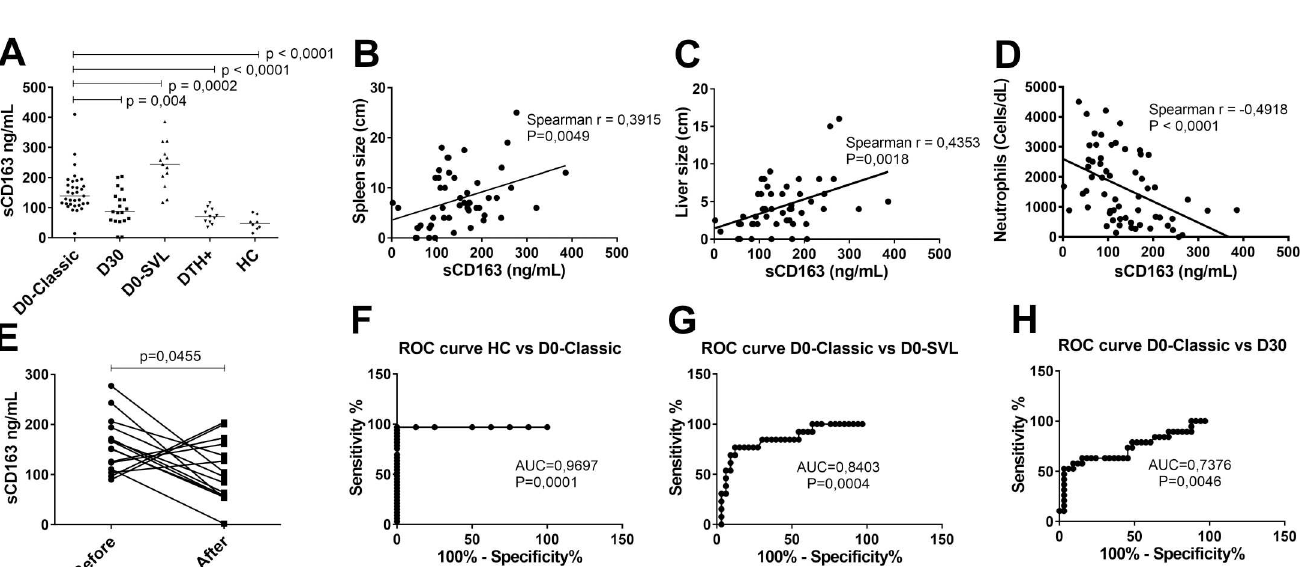
PLOS NeglectedTropical Diseases | https://doi.org/10.1371/journal.pntd.0005486 March 29,